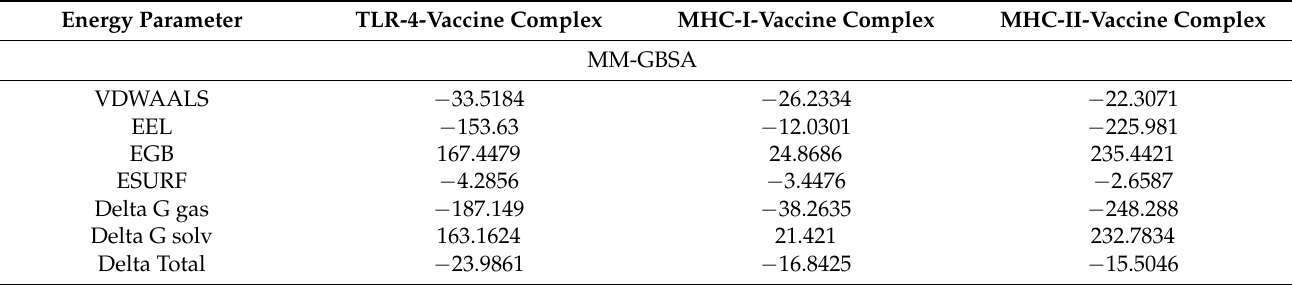
Table 9. MM-GBSA binding energy calculation. The energy values are described in kcal/mol.